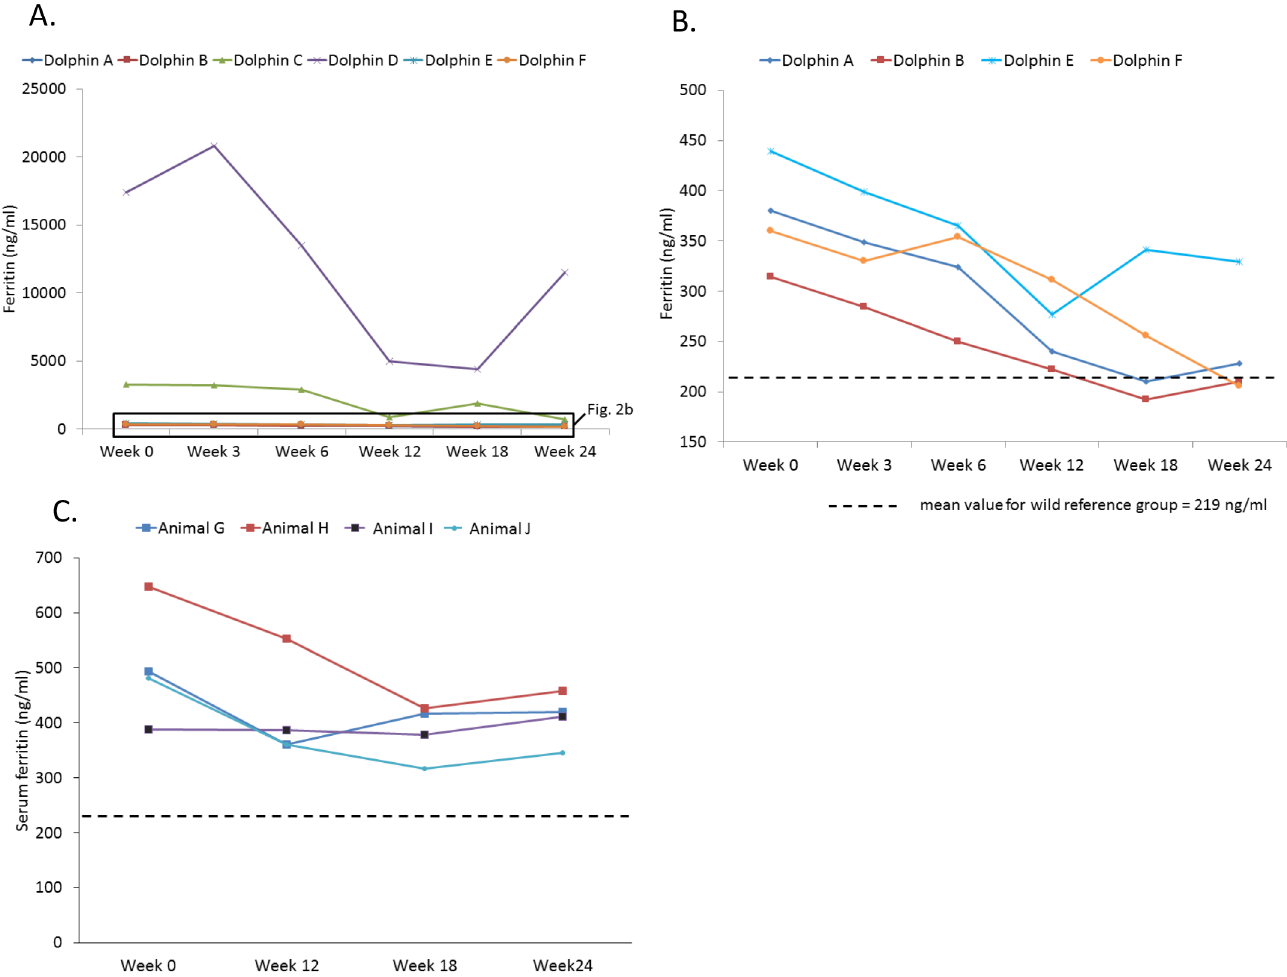
Fig 2. Serum ferritin levels in bottlenose dolphins during a 24-week feeding study, including A) dolphins on a modified diet with an average increased dietary intake of heptadecanoic acid (C17:0) from 400 to 1,700 mg/day (n = 6), B) dolphins on the modified diet (removing two high outlier dolphins), and C) reference dolphins. The dashed line indicates the mean value for the Sarasota Bay reference